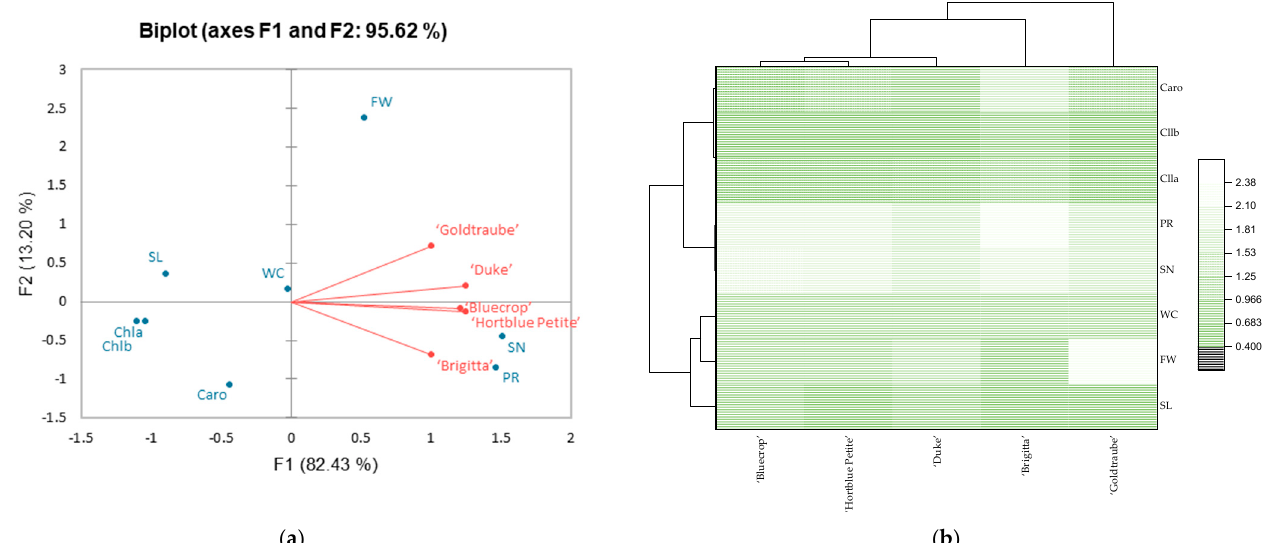
Figure 5. ( a ) Principal component analysis biplot obtained for five highbush blueberry cultivars (Bluecrop, Brigitta Blue, Duke, Goldtraube Hortblue Petite) and drought tolerance efficiency calculated on the basis of the eight growth and physiological indicators: SL, SN, PR, FW, WC, Chla, Chlb and Caro. The first two components explained 95.62% of the data variance. ( b ) Hierarchical clustering and heatmap visualization of the highbush blueberry cultivars based on the drought tolerance efficiency. Columns indicate the highbush blueberry cultivars and rows indicate the drought tolerance efficiency which was calculated for the eight growth and physiological indicators: SL, SN, PR, FW, WC, Chla, Chlb and Caro. The white and green colored cells represent the positive correlation between samples. The dendrogram of the rows resulted from the correlation between the drought tolerance efficiency for the eight growth and physiological indicators; the column dendrogram showed the correlation between the five highbush blueberry cultivars. Different concentrations of polyethylene glycol (PEG 6000): 0 g/L, 10 g/L, 20 g/L, 30 g/L, 40 g/L, 50 g/L. were added to induce drought stress in the culture medium [Woody Plant Medium (WPM) + 100 mg/L Sequestren 138 + 1 mg/L zeatin (Z) + 4 g/L Plant agar, pH = 5]. After 12 weeks treatment (22 ± 1 °C, 32.4 mmol·m − 2 ·s − 1 , 16-h photoperiod), 8 indices were measured and drought tolerance efficiency of each cvs. of each index were calculated: SL-shoot length (cm); SN-average number of shoots/culture vessel), (PR-proliferation rate; FW-fresh weight (mg); WC-Water content (%); Chla-chlorophyll a (mg/g FW); Chlb-chlorophyll b (mg)/g FW); Caro-Carotenoid (mg/g FW).